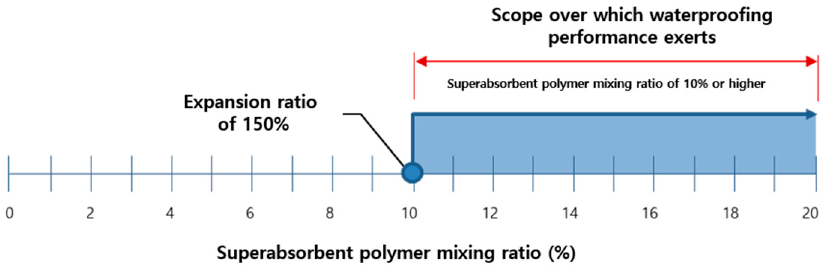
Figure 11. The superabsorbent polymer mixing ratio for waterproofing performance of water-ex- pandable polyurethane. expandable